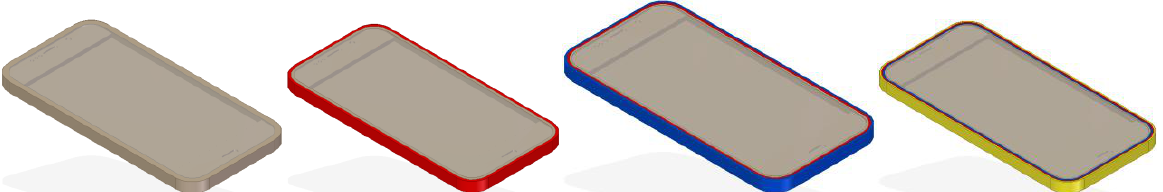
Fig. 2. Different number of casing laminates (a) single (b) two (c) Casing (d)